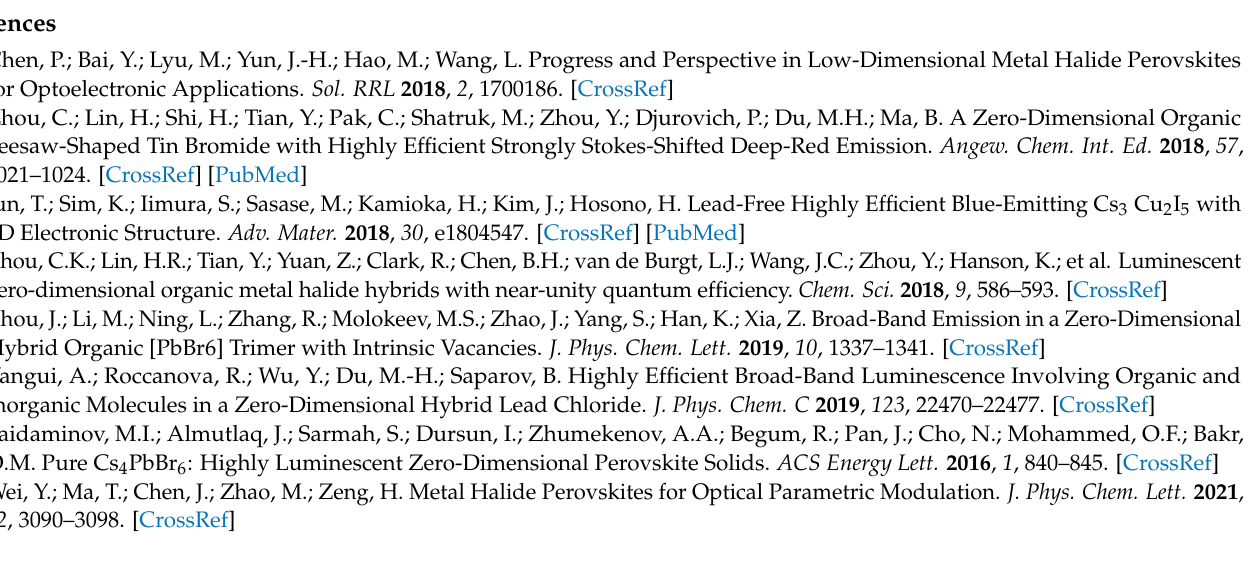
Stokes shift, FWHM, and PLQY of the low- dimensional metal halide with blue emission. Table S5. Simulation table of bond angles of ground state and excited state. Table S6. Simulation table of bond lengths of ground state and excited state. Figure S1. PXRD pattern result of (TPA) 2 PbBr 4 powders after one month. Figure S2. Photostability of (TPA) 2 PbBr 4 powders under continuous illumination using a high power mercury lamp. Figure S3. TG curve of (TPA) 2 PbBr 4 powders. Figure S4. PL and PLE spectra at RT and 77 K of (TPA)2PbBr4 SCs crystals. Figure S5. The PL spectra of (TPA) 2 PbBr